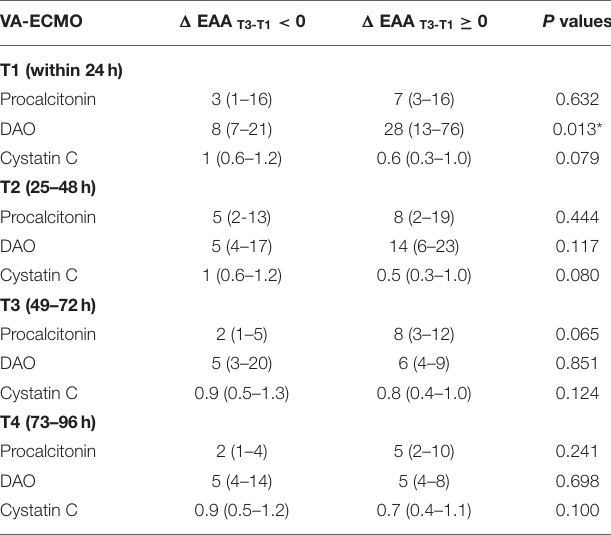
TABLE 5 | Biomarker levels in VA-ECMO patients with or without elevated EAA levels at T3. VA-ECMO